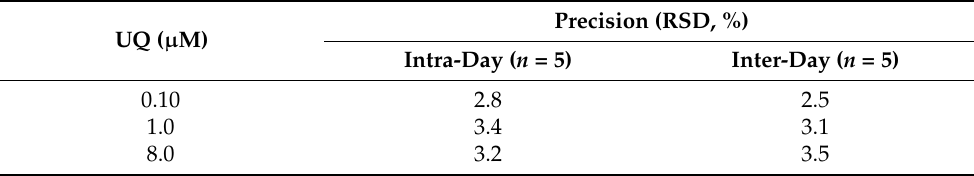
Table 1. The results of the reproducibility study of the HPLC-CL with electrolytic reduction.